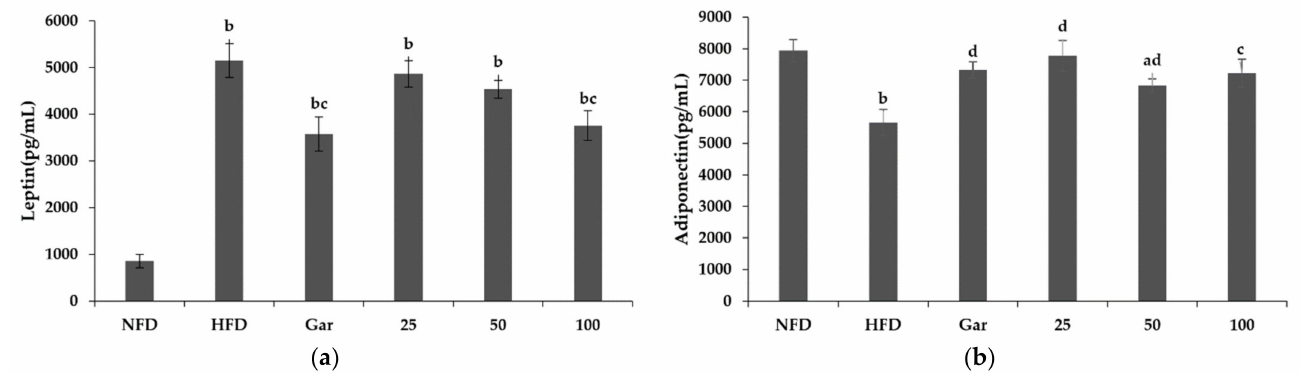
Figure 6. Changes in the leptin and adiponectin levels caused by hot-water barley sprout extract (BSE). ( a ) Leptin levels in serum. ( b ) Adiponectin levels in serum. Statistical analysis was performed using a t -test. a p < 0.05 and b p < 0.01 compared with the NFD group. c p < 0.05 and d p < 0.01 compared with the HFD group. NFD: normal-fat diet; HFD: high-fat diet; Gar: Garcinia cambogia 100 mg/kg/day; 25, BSE 25 mg/kg/day; 50, BSE 50 mg/kg/day; 100, BSE 100 mg/kg/day. Values are the mean ± SD of six mice per